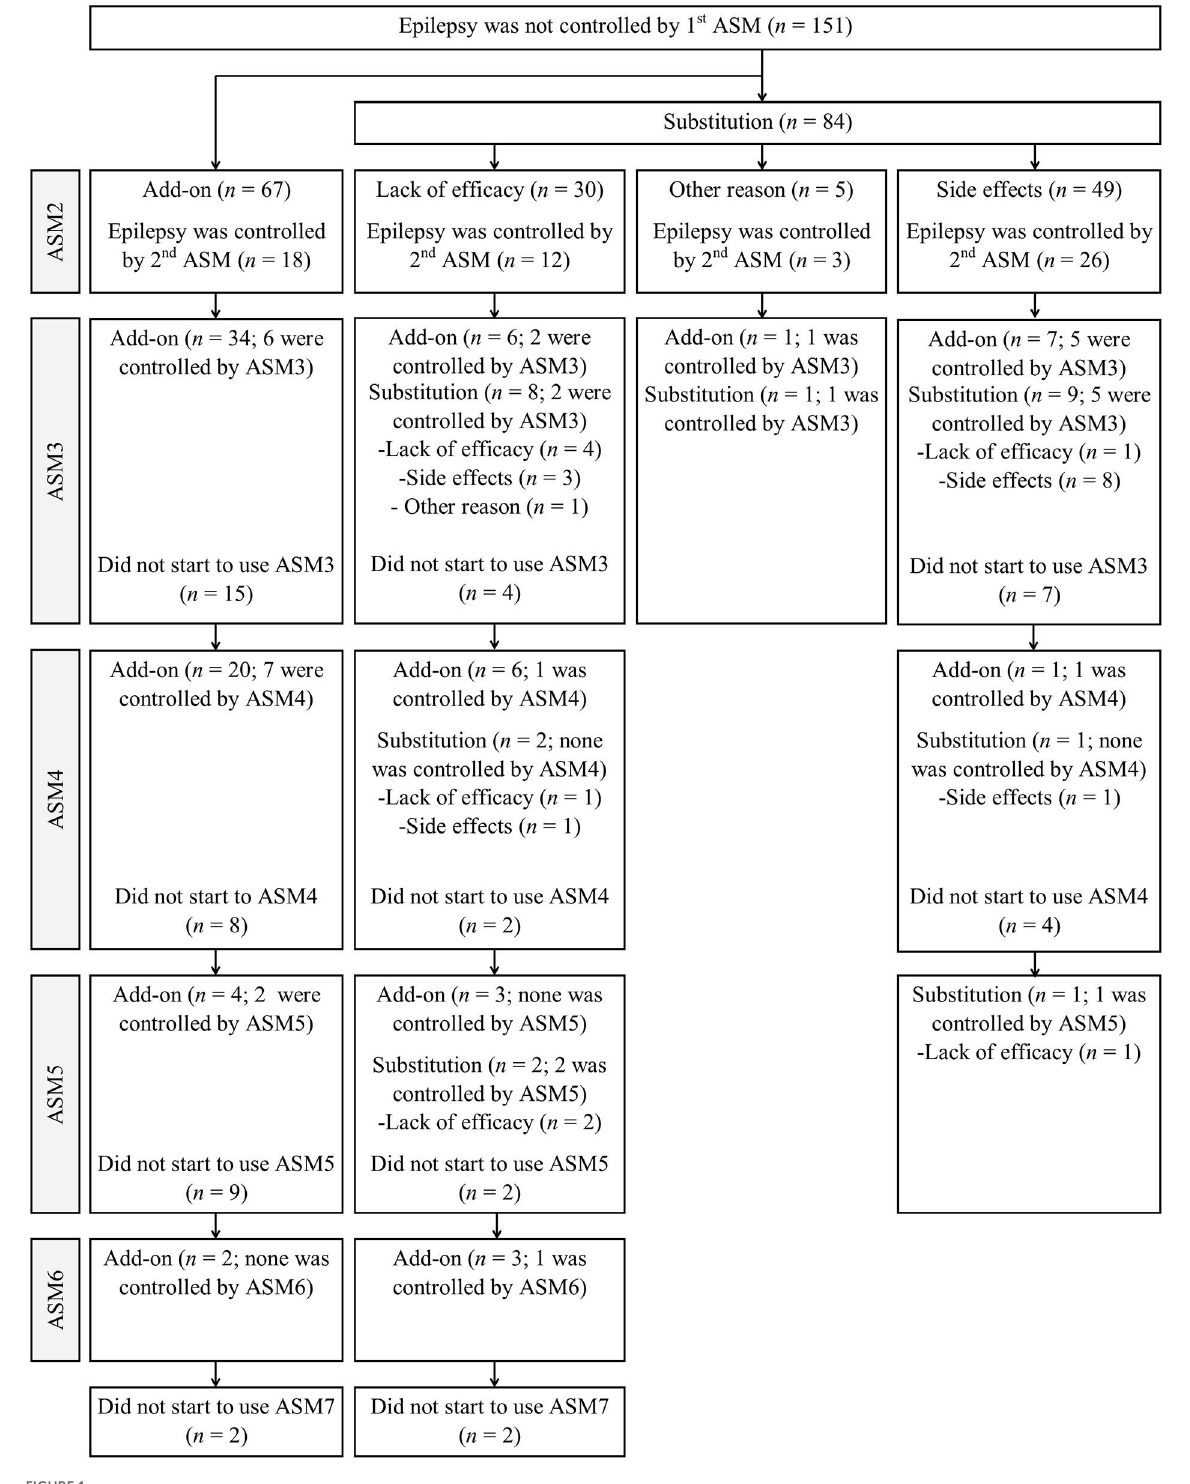
FIGURE1 Patient responses to different combinations of the add-on and substitution ASMs after seizure